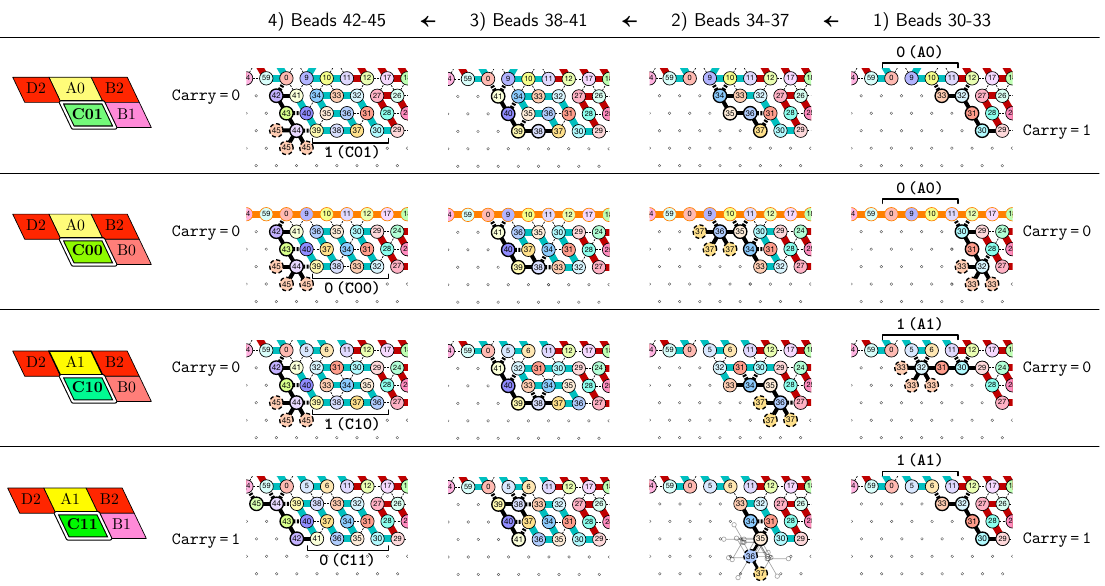
Figure 13. An illustration of how the module C applies a different function which results in different foldings according to the initial state of the molecule (carry = 0 or 1) at the beginning of the folding of the module, and to the environment (the bit 0 or 1 encoded) read above by the function. This figure is meant to be read from right to left (zig pass Ð